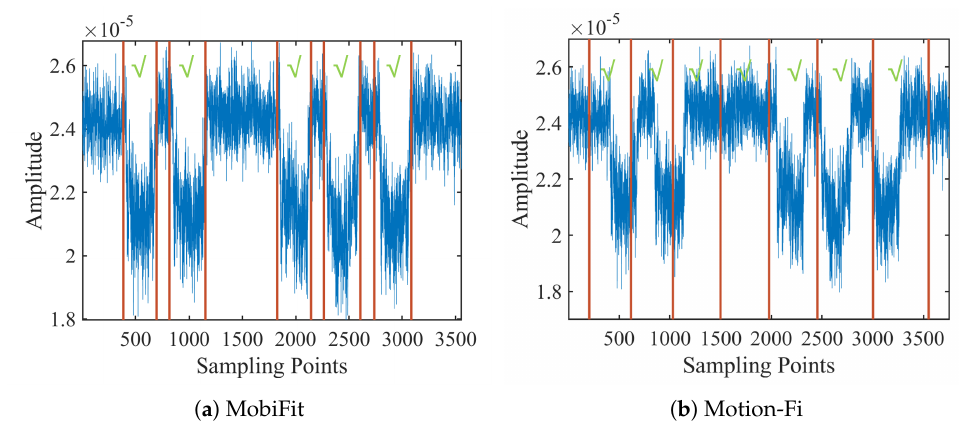
Figure 18. Counting comparison with checks labeled repetitions.